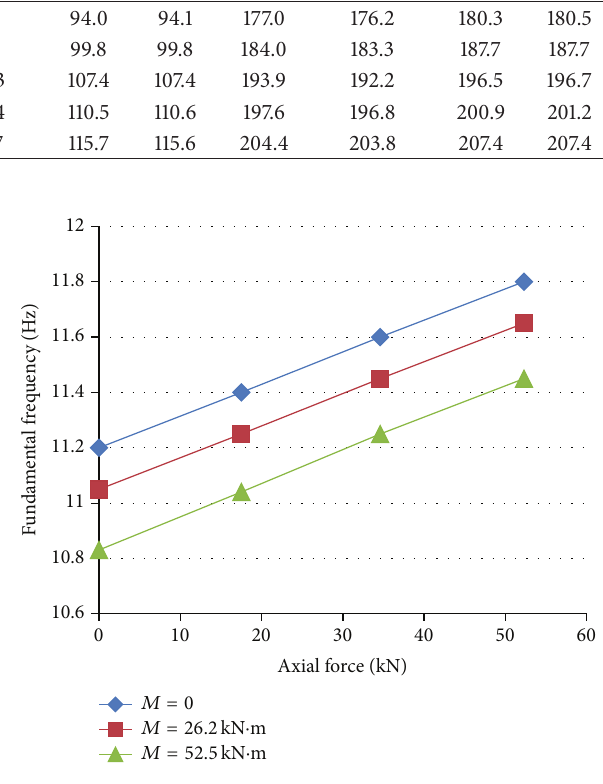
Figure 7: Variation of natural frequencies when tensile force and end moment are applied for pinned-pinned boundary condition.